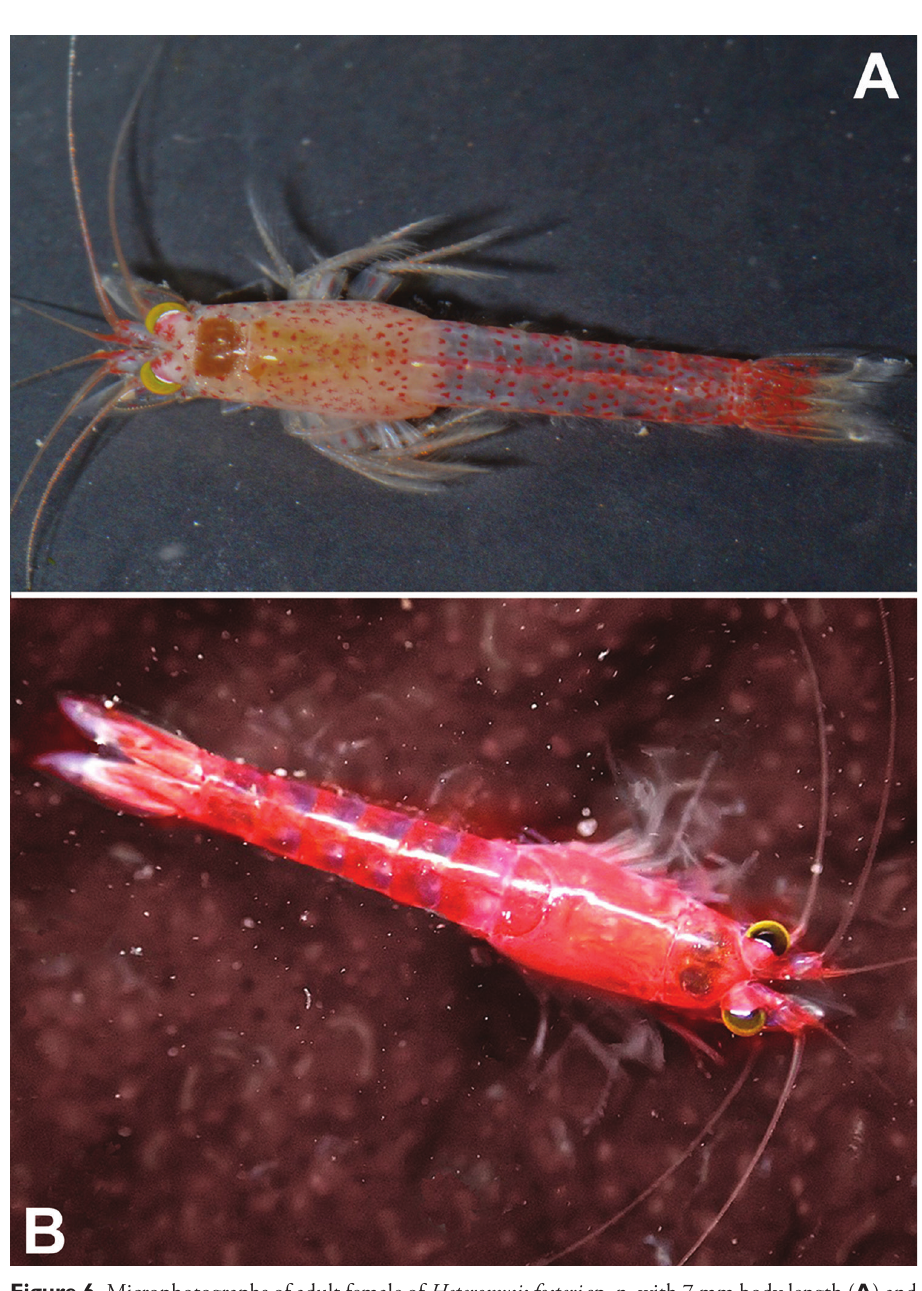
Figure 6. Microphotographs of adult female of Heteromysis fosteri sp. n. with 7 mm body length ( A ) and of adult male of Heteromysis octopodis sp. n. with 9 mm ( B ), each from Miller’s Point, Cape Peninsula, South Africa. A laboratory photo by C.L. Griffiths B in situ image by Craig Foster, this last with back- ground cleaned with electronic